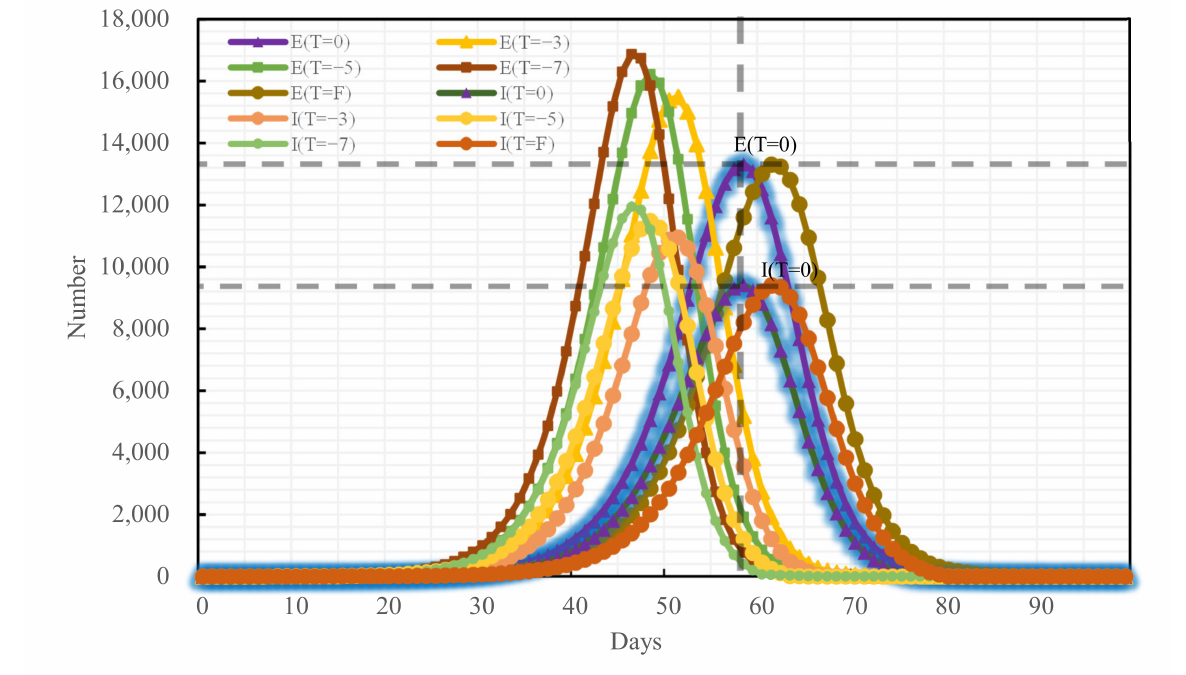
Figure 10. Epidemic trend under the road traffic control policy promulgated at distinct time nodes.